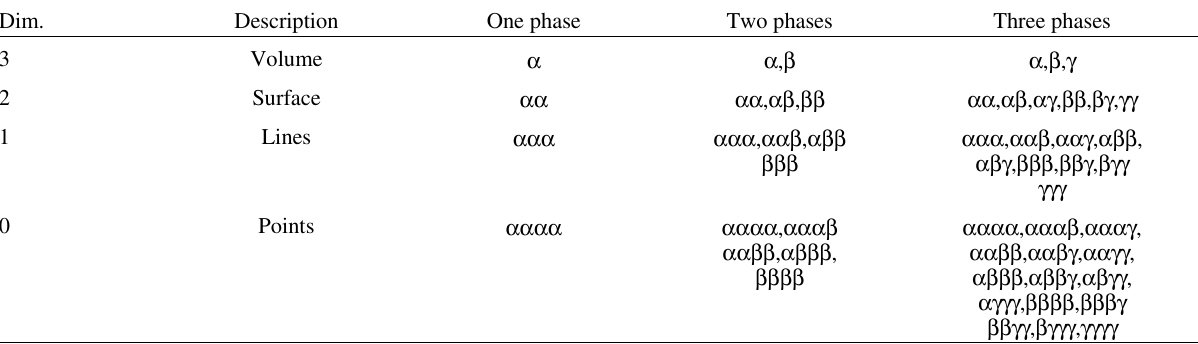
Table 1. Feature list table: three dimensional structures. Dim.